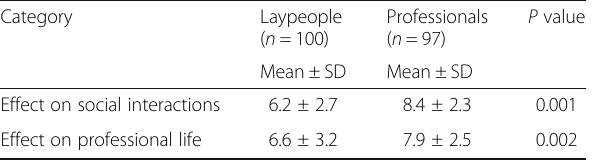
Table 3 Perceived influence of CLP on social interactions and professional life among laypeople and healthcare professionals